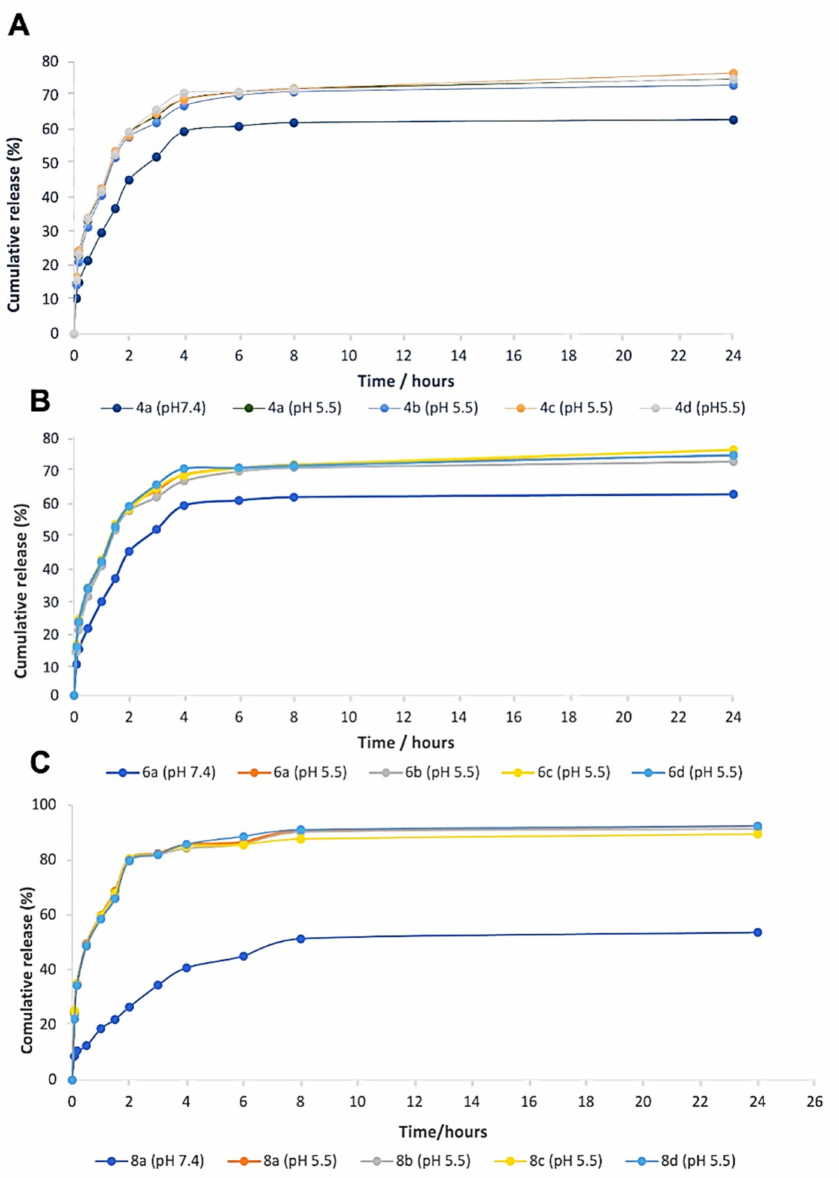
Figure 4. The cumulative releasing property of biomimetic thymine dimers 4a - d ( A ) and photo- adducts 6a - d ( B ) and 8a - d ( C